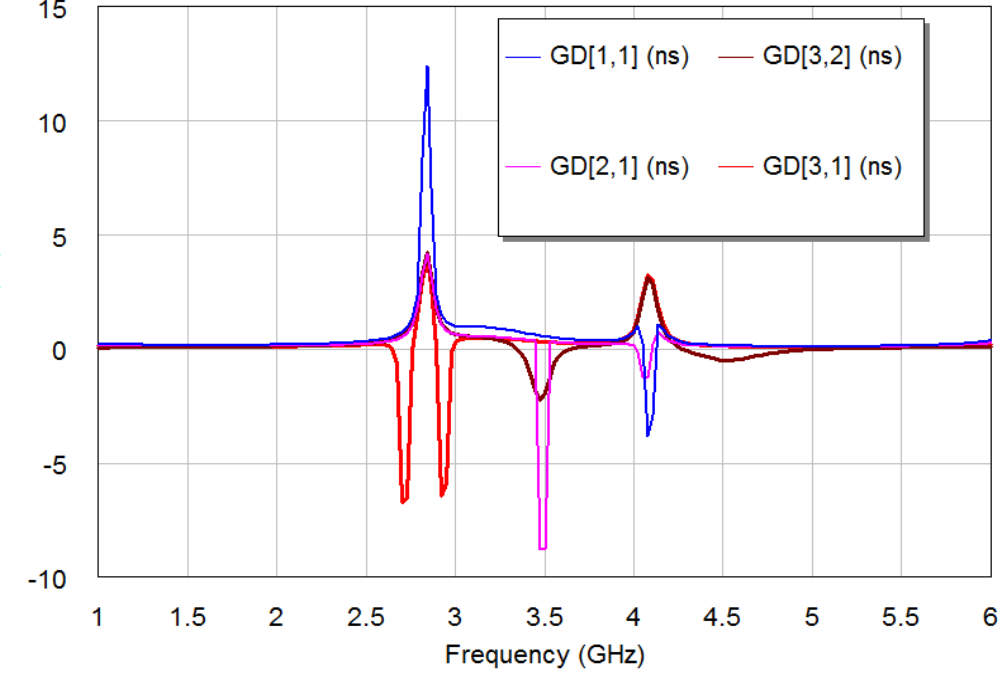
Figure 12. Group delay response for the designed diplexer. Table 1. Negative group delay values.